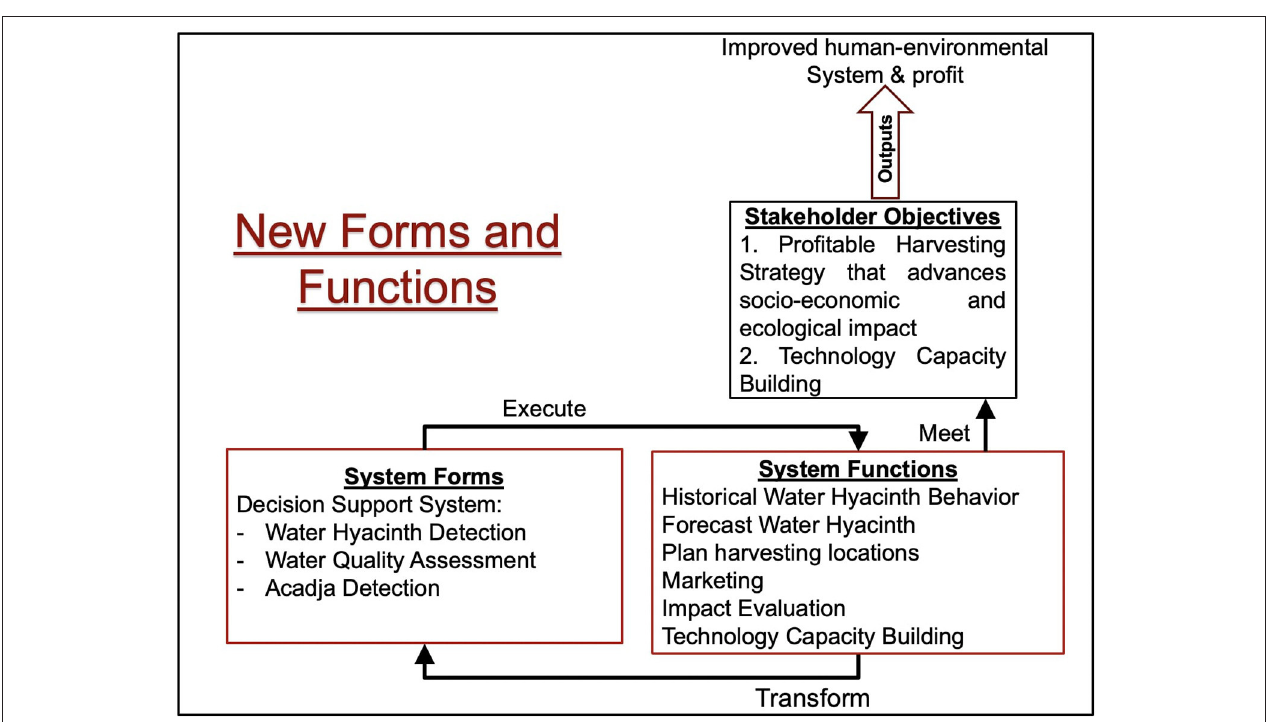
FIGURE 7 | Summary of the proposed forms which will execute functions that meet stakeholder system objectives. Credit: The